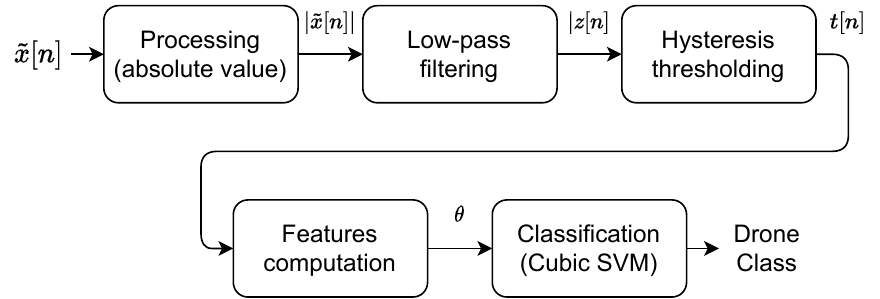
Figure 3. Structure of classification